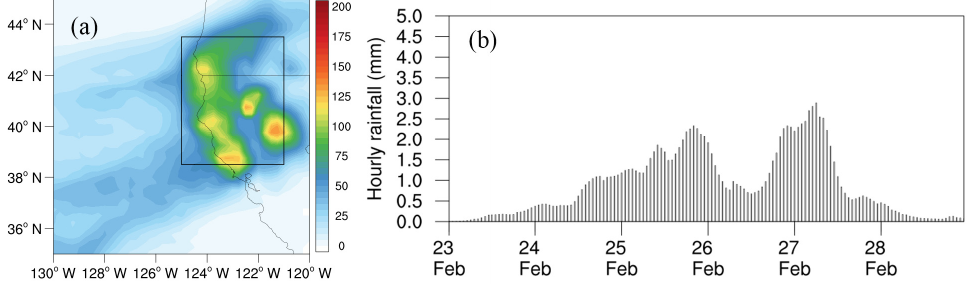
Figure 1. ( a ) The 48-h accumulated rainfall (in mm) during 25–27 February 2019. The rainfall area (38.5–43.5 ◦ N, 125–121 ◦ W) is boxed. ( b ) Time series of the hourly rainfall averaged over the box in ( a